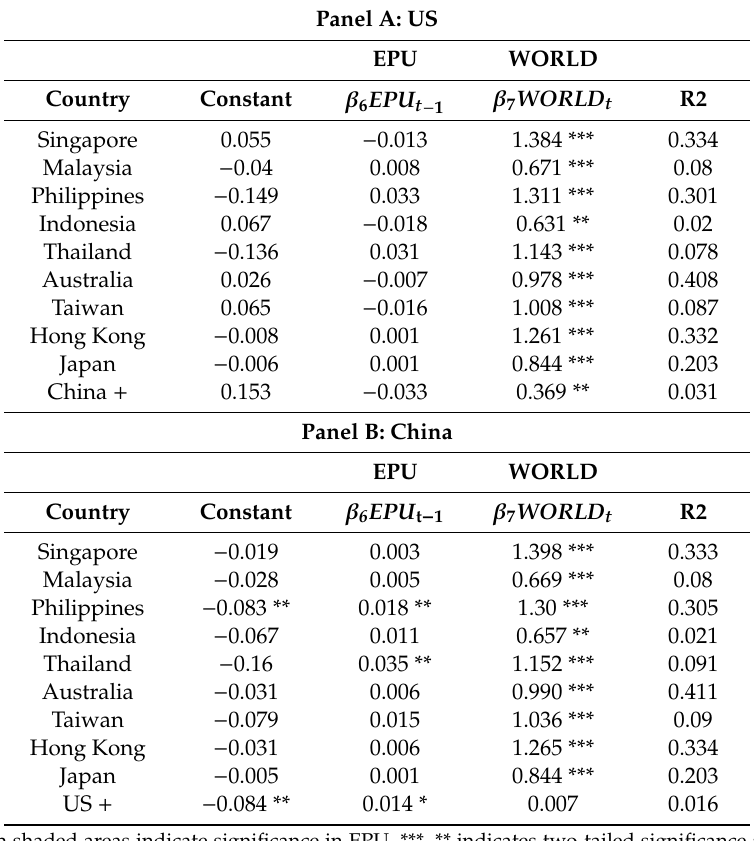
Table 5. Linear regression of the APAC REERs on the EPU of the US and China: January 1988–April